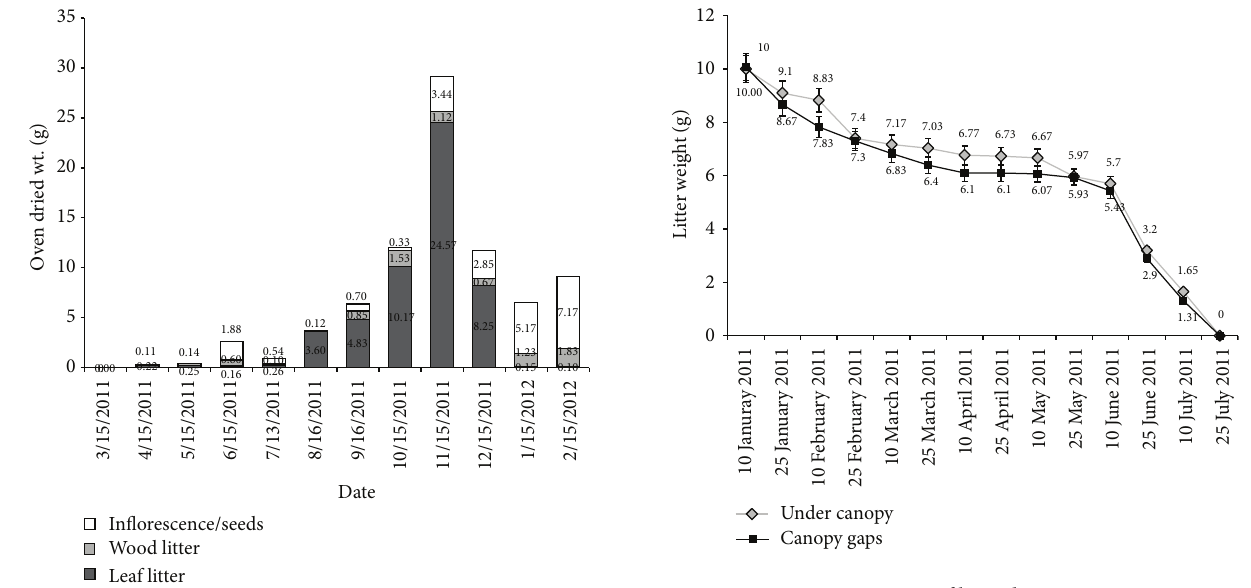
Figure 4: Partitioning of litter into leaf, wood, and inflores- cence/seed across different months in under-canopy.